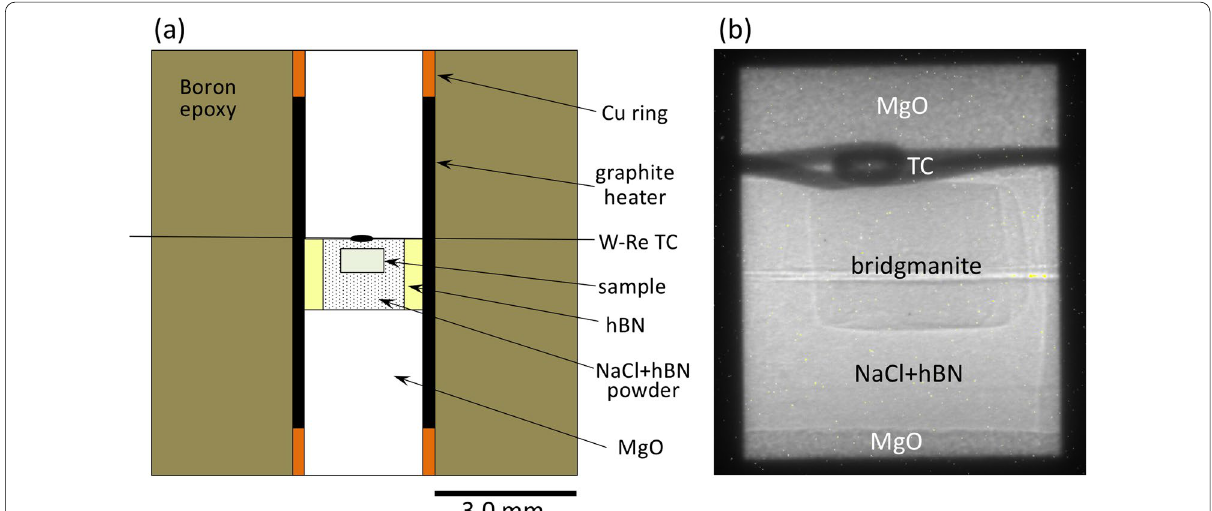
Fig. 1 Sample assembly used in the back-transformation experiments (TEL6 system). a Cross section of the sample assembly. b Its radiography image around the sample at a load of 5 ton (Run